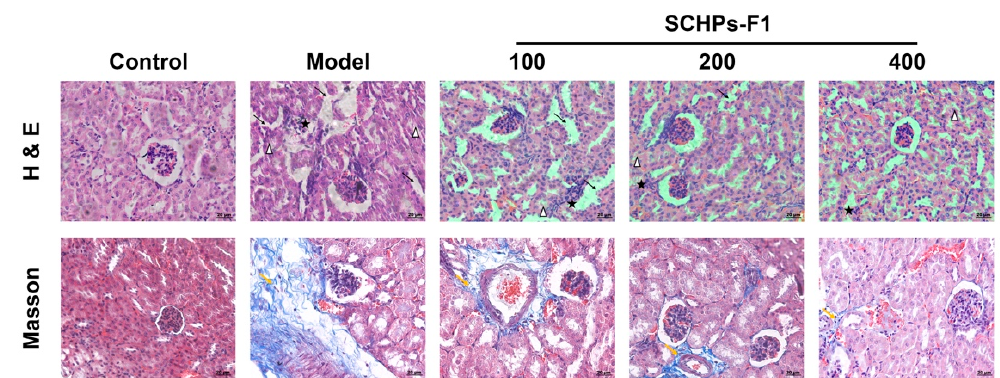
Figure 7. Effects of SCHPs-F1 treatment on the kidney pathomorphology in CTX-exposed mice (×400 magnification). H&E-stained images of kidney tissue paraffin sections showing inflammatory cell infiltrate (stars), mesangial matrix dilation (arrows), tubular necrosis and degeneration (arrowheads); Masson’s trichrome-stained images of kidney tissue paraffin sections showing blue-stained collagen fibrous connective tissue (yellow arrows).